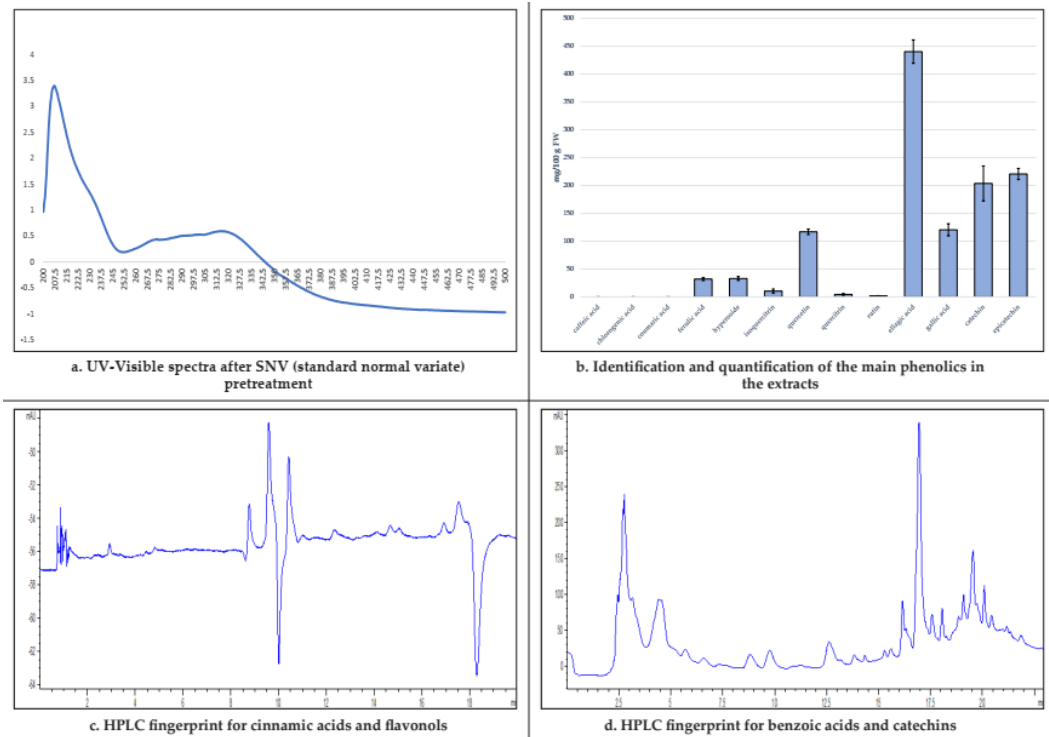
Figure 1. UV-Vis spectra ( a ), bioactive compound quantification ( b ), and HPLC fingerprint ( c , d ) of the T. tomentosa bud ‐ extracts.